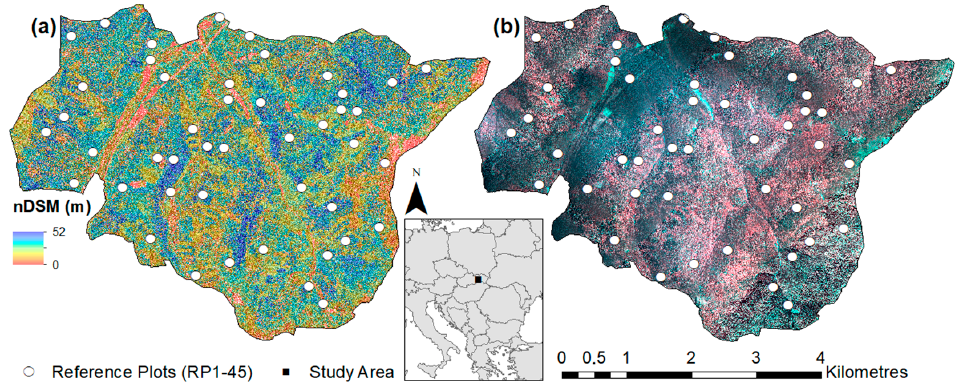
Figure 1. Location of the study area: ( a ) normalized digital surface model; and ( b ) color-infrared aerial photograph.